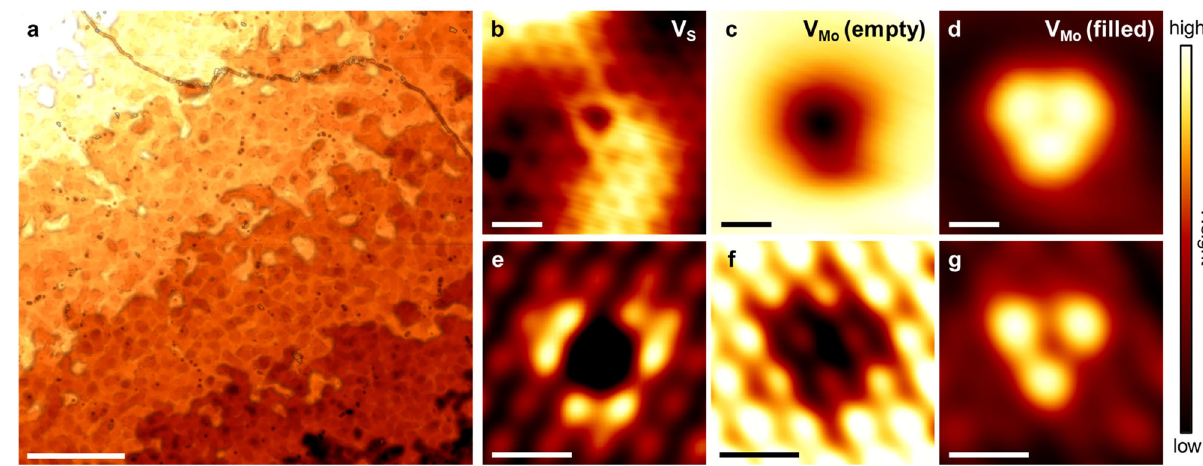
Fig. 1 Common point defects found in monolayer MoS 2 fi lms. a Large-area STM topography showing the native defects on a semiconducting region of MoS 2 ( V set = 1.0 V, I set = 30 pA). Scale bar represents 50 nm. b Atomic resolution STM topography acquired over a sulfur vacancy ( V set = 100 mV, I set = 100 pA). c , d Atomic resolution of a molybdenum vacancy acquired in the empty ( V set = 1.0 V) and fi lled ( V set = − 2.0 V) state, respectively ( I set = 100 pA). e – g Constant current STM topography simulations of the defects in panels b – d with bias set to V = 100 mV, 1.0 V and − 1.0 V, respectively. Scale bars for panels b – g represent 0.5 Fig. 1a. The step-like features on the surface do not come from multiple layers of MoS 2 but result from the impression of the terraced surface of the c -axis cut sapphire substrate on which the fi lm was originally grown 29 . The high-resolution STM topographies